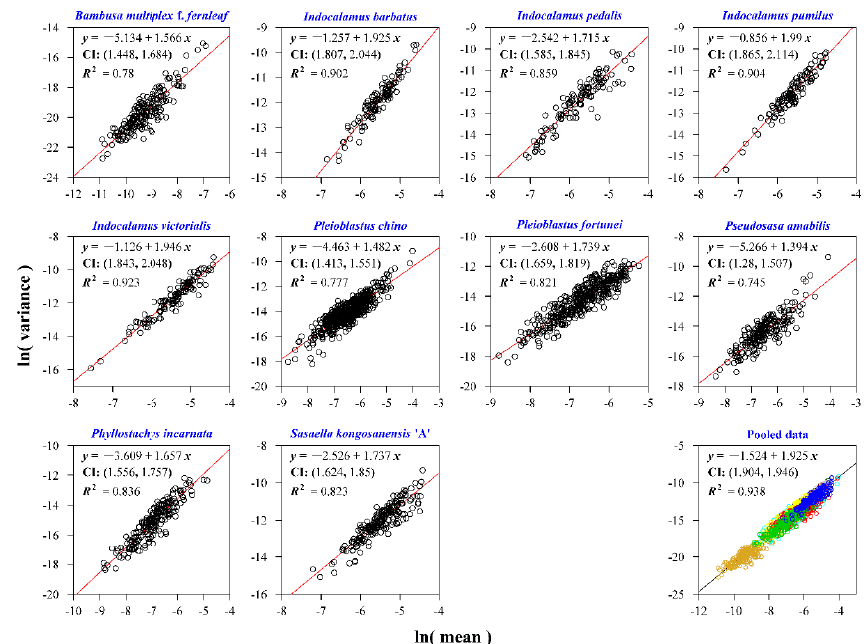
Figure 4. Taylor’s power law for the measure of leaf bilateral symmetry for 10 species of Bambusoideae (Poaceae). The detailed Latin name and collecting information can be found in Table S2. The small open circles represent the observations, and the straight line represents the fitted regression line based on the ordinary least-squares method. ‘CI’ represents the 95% confidence interval of the estimate of the slope of the fitted linear equation. Forests 2018 , 9 , 500